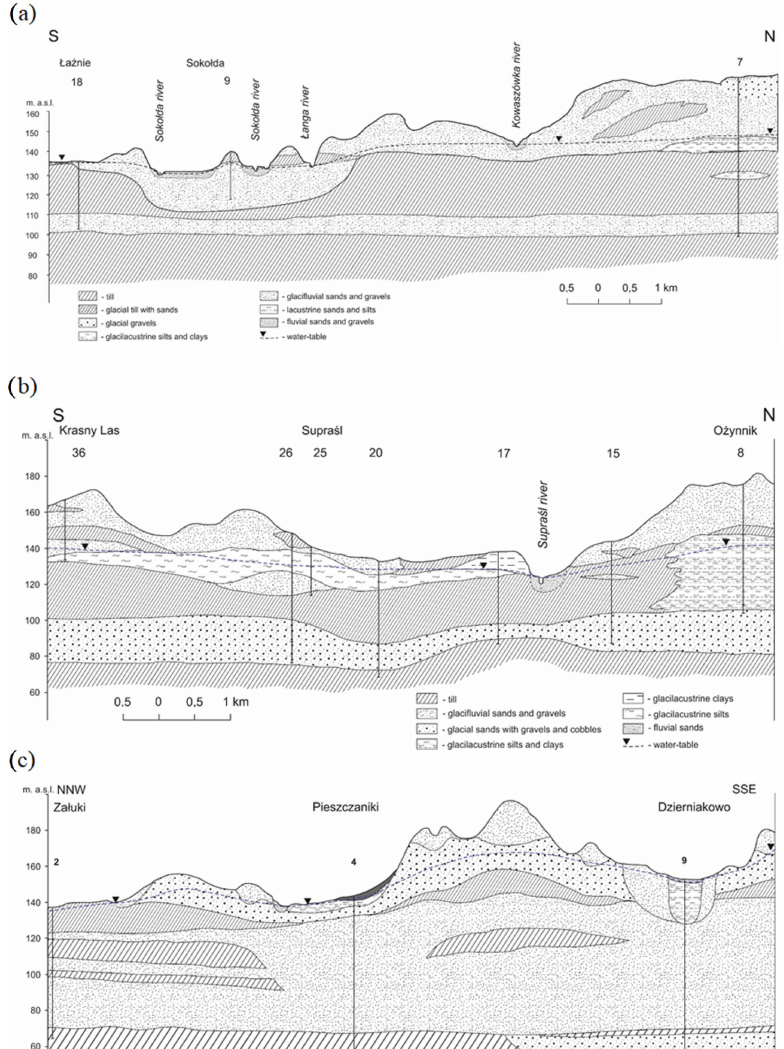
Figure 2. Hydrogeological cross-section through the Knyszyn Forest: the central part of Ła˙znie- Kowalewszczyzna ( a ), the central part of Krasny-Las O˙zynnik ( b ), and the eastern part of Załuki- Dzierniakowo ( c ).